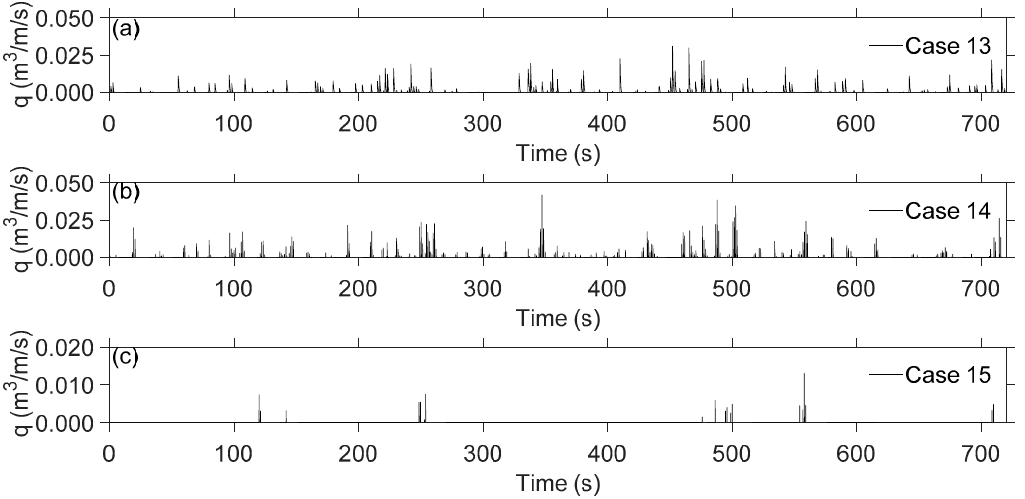
Figure 2. The time series of wave overtopping simulated by the SWASH model. ( a ), ( b ) and ( c ) represent Case 13, Case 14 and Case 15 in Table 1, respectively.